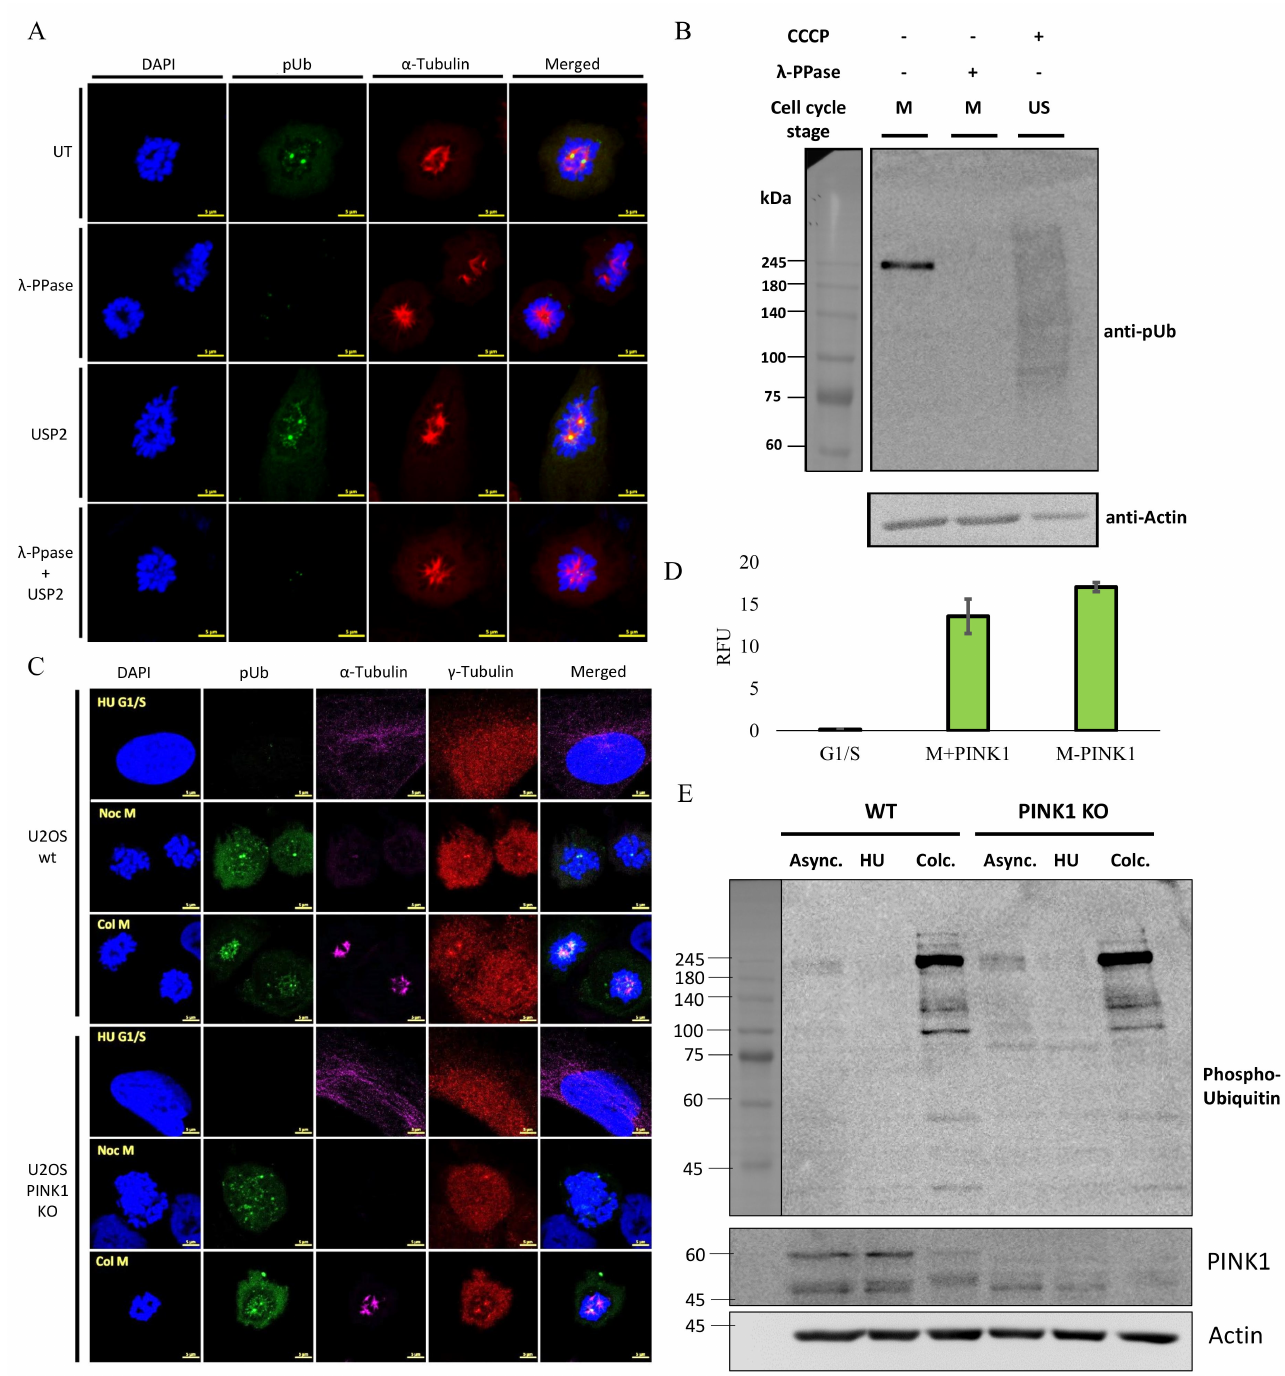
Figure 2. Signal from pUb during mitosis is independent of PINK1 and is abolished by λ —PPase. ( A ) Confocal images of mitotic cells treated with λ —PPase, USP2 and both enzymes and stained with pUb (green), α —Tubulin (red) antibodies and DAPI (blue); ( B ) Western blot analysis using pUb antibody of mitotic lysate with and without λ —PPase treatment. A positive control for presence of pUb are extracts of unsynchronized U2OS cells treated with CCCP; ( C ) confocal images of wt and PINK1 KO U2OS cells stained with antibodies for pUb (green), α —Tubulin (magenta), γ —Tubulin (red) and DAPI (blue) in different cell cycle stages; ( D ) quantification of pUb signal in C ( γ —Tubulin mask) from two independent experiments (>100 cells each); ( E ) Western blot analysis using pUb antibody of WT and PINK1 KO U2OS cells in different cell cycle stages. Representative image of two independent experiments. Western blot signals are HRP luminescence. Scale bars are 5